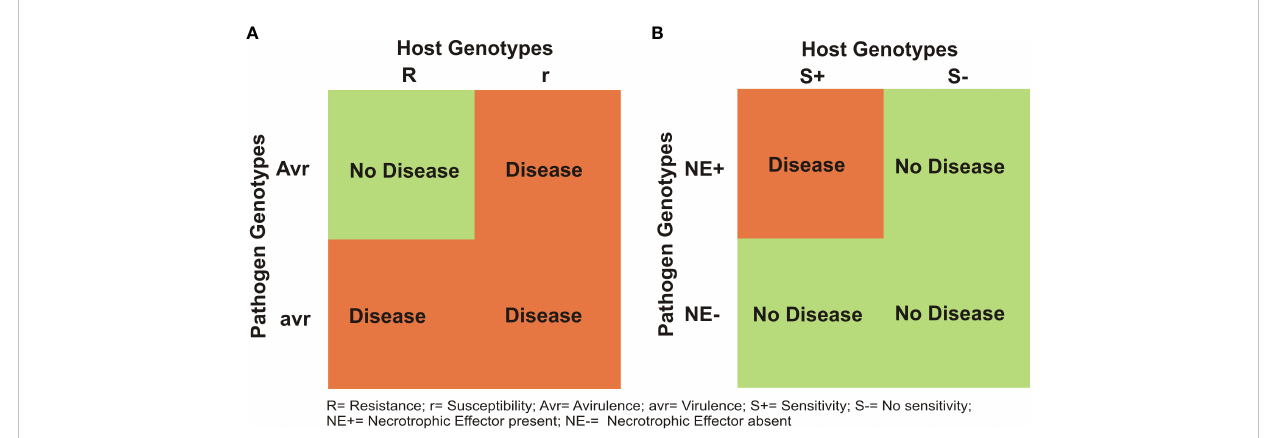
FIGURE 2 Two different models for host- pathogen interactions in plants: (A) gene-for gene (GFG) model, proposed by Flor (1956) and (B) an inverse gene-for gene (IGFG) model that was discovered recently in a number of necrotrophic diseases in